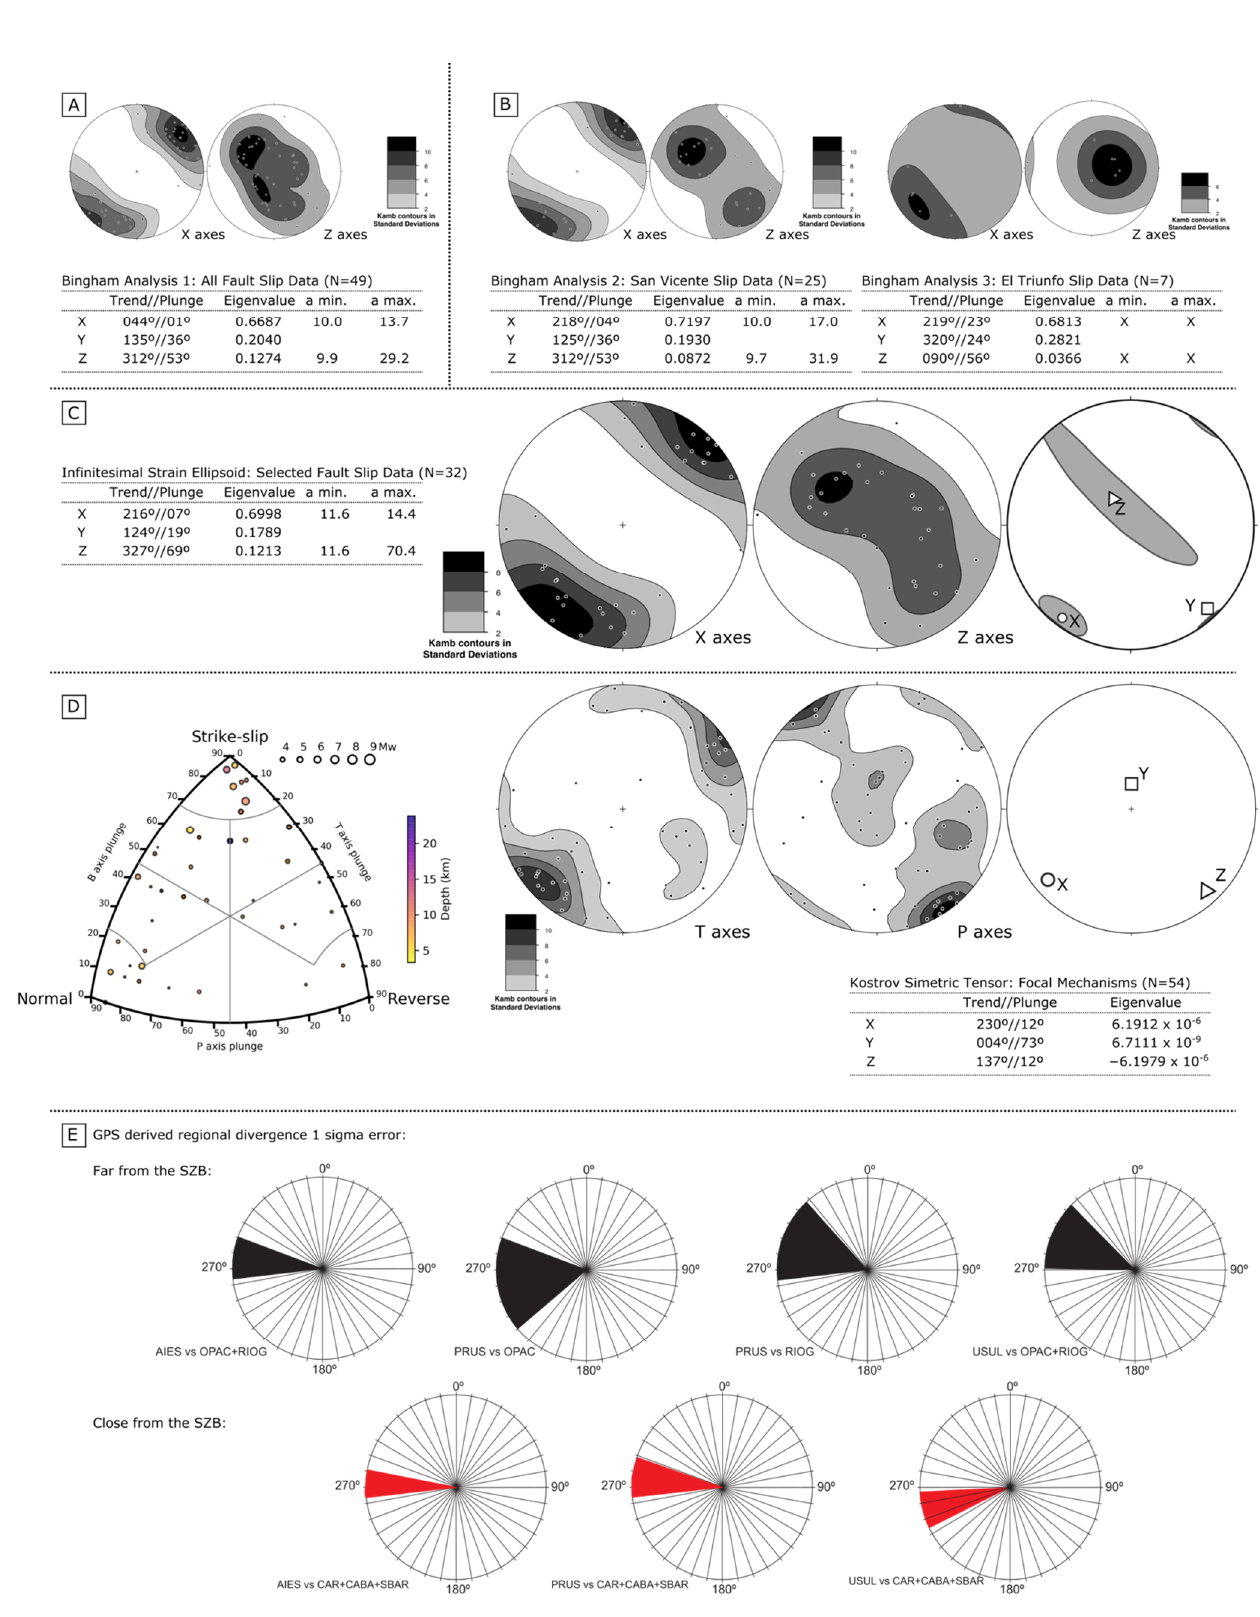
Figure 4. Equal area, lower hemisphere projection of: ( A ) X and Z axes derived from the analysis of the fault slip data compiled from all across the ESFZ (Kamb contours with a significance level of 3σ and contour intervals of 2σ); ( B ) X and Z axes of the areas enclosing San Vicente and El Triunfo faults, respectively; and ( C ) orientation of the principal axes (X and Z) of the incremental strain ellipsoid for selected fault slip data (see main text). (right diagram) 95% confidence cones are also represented in the elliptic base for X and Z. Tables show the three main axes’ orientation of a